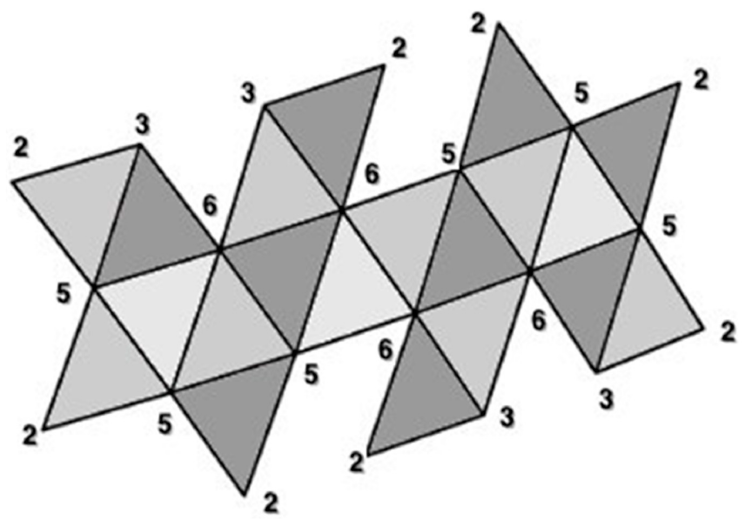
Figure 15. Vertex degrees, given by the number of edges connected to each vertex, are numbered on a Dürer net of an icosahedron. The net contains 20 faces (equilateral triangles; viral capsomeres) with 22 external vertices and 22 external edges. In terms of Euler’s formula V − E + F = 2, this polygon has only 2 faces (all of the colored net is one face and area outside of its boundary is the second face: so 22 − 22 + 2 = 2. Note that once the net is folded, the resulting icosahedron has V = 12, E = 30, and F = 20. This net can be distinguished from the other 43,279 cuts of an icosahedron to generate a planar configuration by a unique Hamiltonian circuit of the degrees of the vertices: beginning with the top left vertex (2-3-6-3-2-6-5-2-5-2-5-2-3-6-3-2-6-5-2-5-2-5-). It is important to distinguish this Hamiltonian circuit from a Hamiltonian path that attaches along one edges of each of the capsomeres [28]. Two additional topological invariants of these structures are the number of vertex connections (see Figure 13) and the number of leaves (see Figure 14). Vertices of degree 6 we will refer to as vertex connections—the edges attached to such vertices are easily joined to one another when the 2D Dürer net if folded into the 3D icosahedron. Vertices of degree 6 on a Dürer net of an icosahedron are called vertex connections. The above configuration thus has 4 vertex